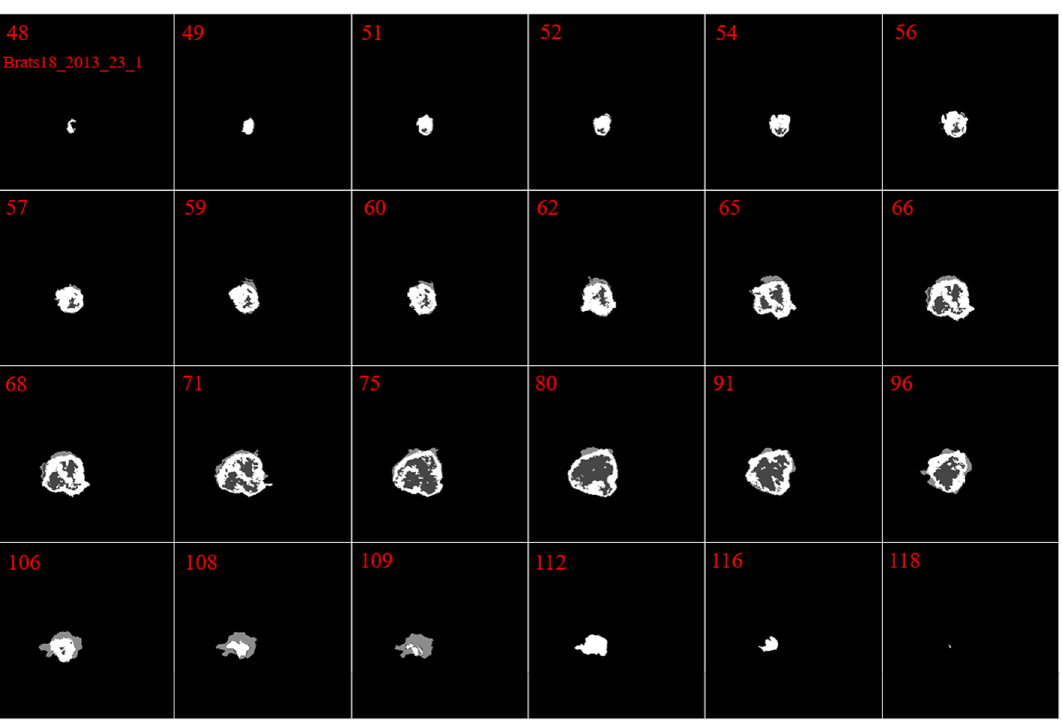
Figure 2. Illustration of the ground truth in 24 different slices in Brats18_2013_23_1. The red numbers indicate the number of the slice.